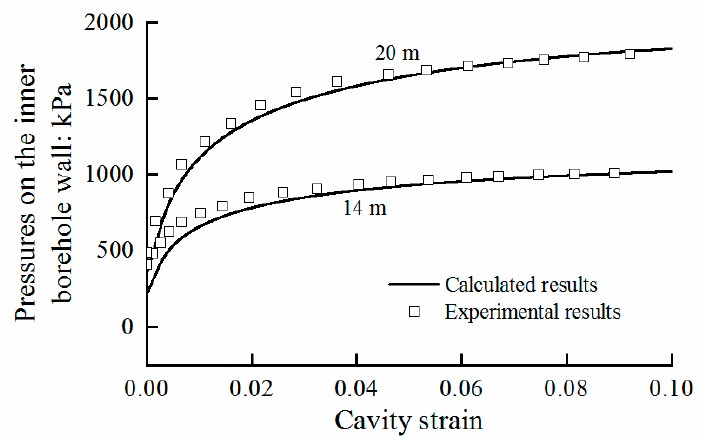
Figure 17. Comparisons of calculated and experimental results for the SBPM tests: cavity strain pressure on the inner borehole wall.